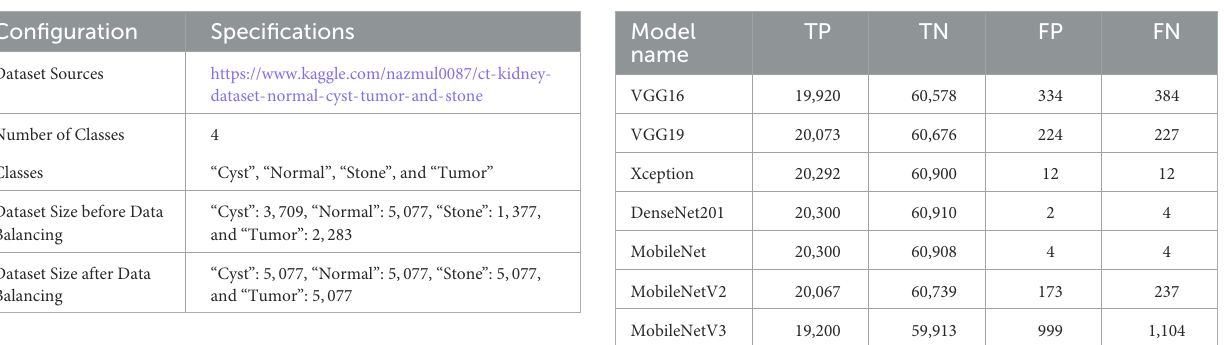
TABLE 7 Four-classes specific experiments configurations. TABLE 8 CM findings for the Four-classes